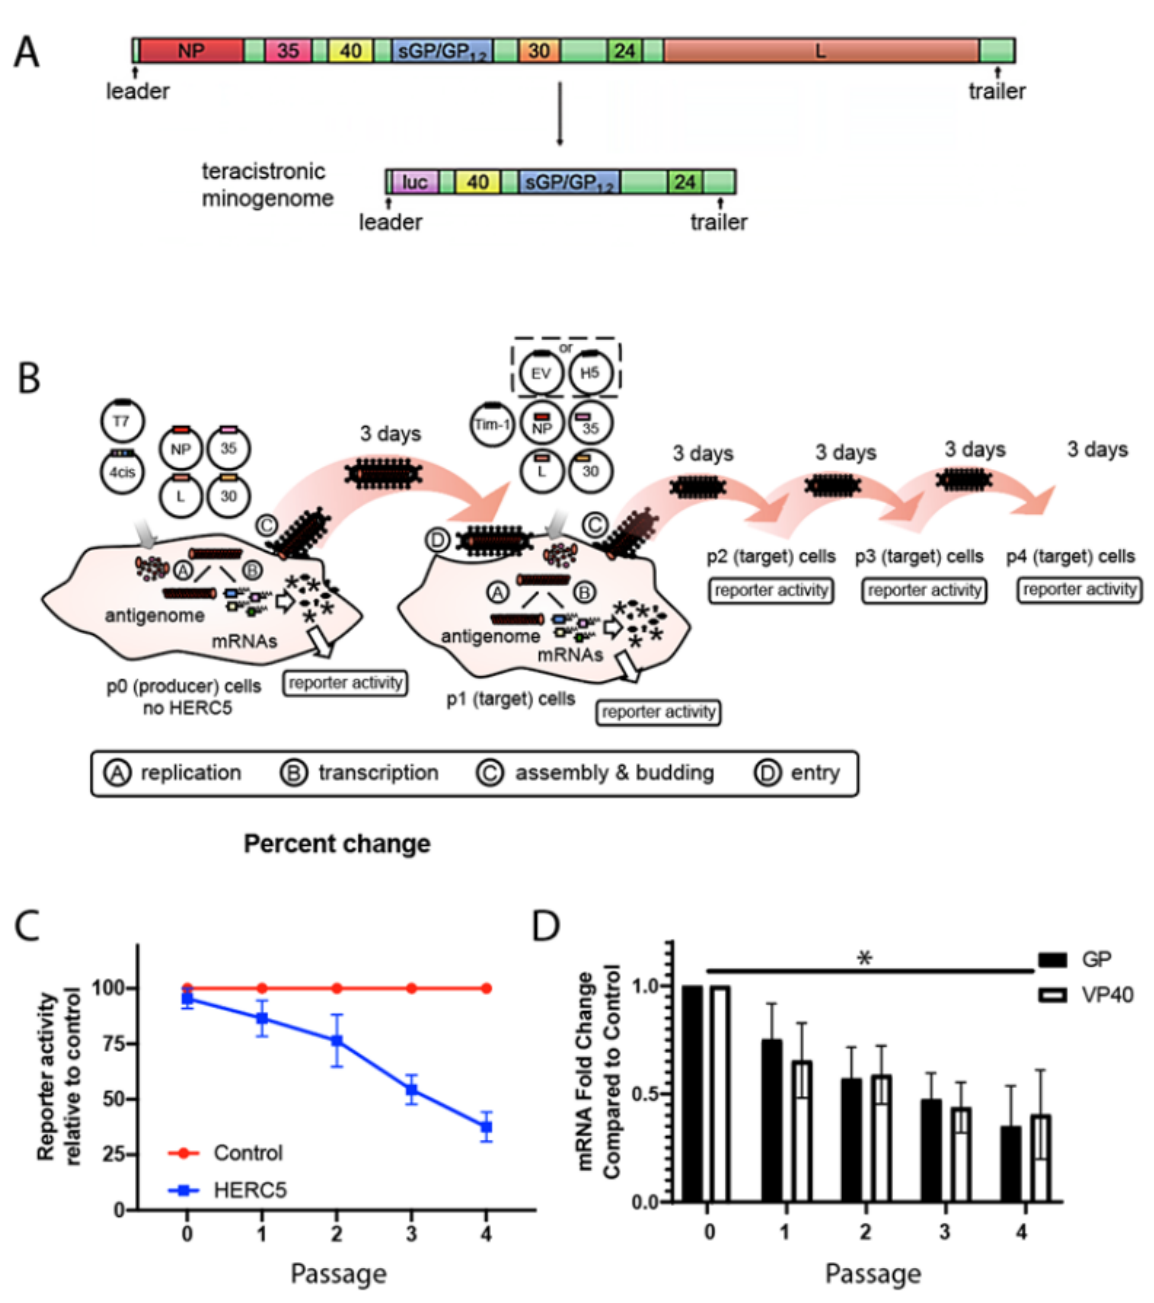
Figure 1. HERC5 inhibits EBOV trVLP replication. ( A ) Schematic depicting EBOV full-length genome and the derived tetracistronic minigenome. ( B ) The trVLP propagation assay. A tetracistronic EBOV minigenome (4cis) is expressed in cells together with the viral ribonucleoprotein complex (RNP) proteins (NP, VP35, VP30 and L). After the initial transcription by a co-expressed T7 polymerase, the minigenome is replicated and transcribed by the RNP proteins. Expression of VP40, GP and VP24 from the minigenome leads to the formation of infectious trVLPs containing minigenomes, which can infect target cells. Multiple infectious cycles can be modeled in cells expressing NP, VP35, L, VP30 and Tim-1 without the need for additional transfections of plasmids carrying VP40, GP and VP24. The figure was adapted from (Watt et al., 2014), copyright © American Society for Microbiology, J. Virol. 88, 2014, 10,511–10,524, doi:10.1128/JVI.01272-14. ( C ) Quantification of